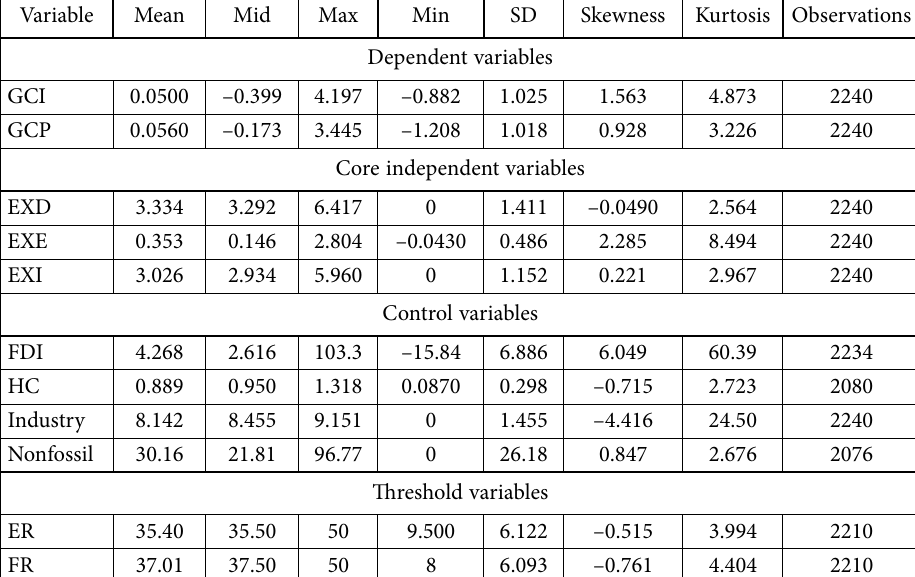
Table A2. Summary of statistical